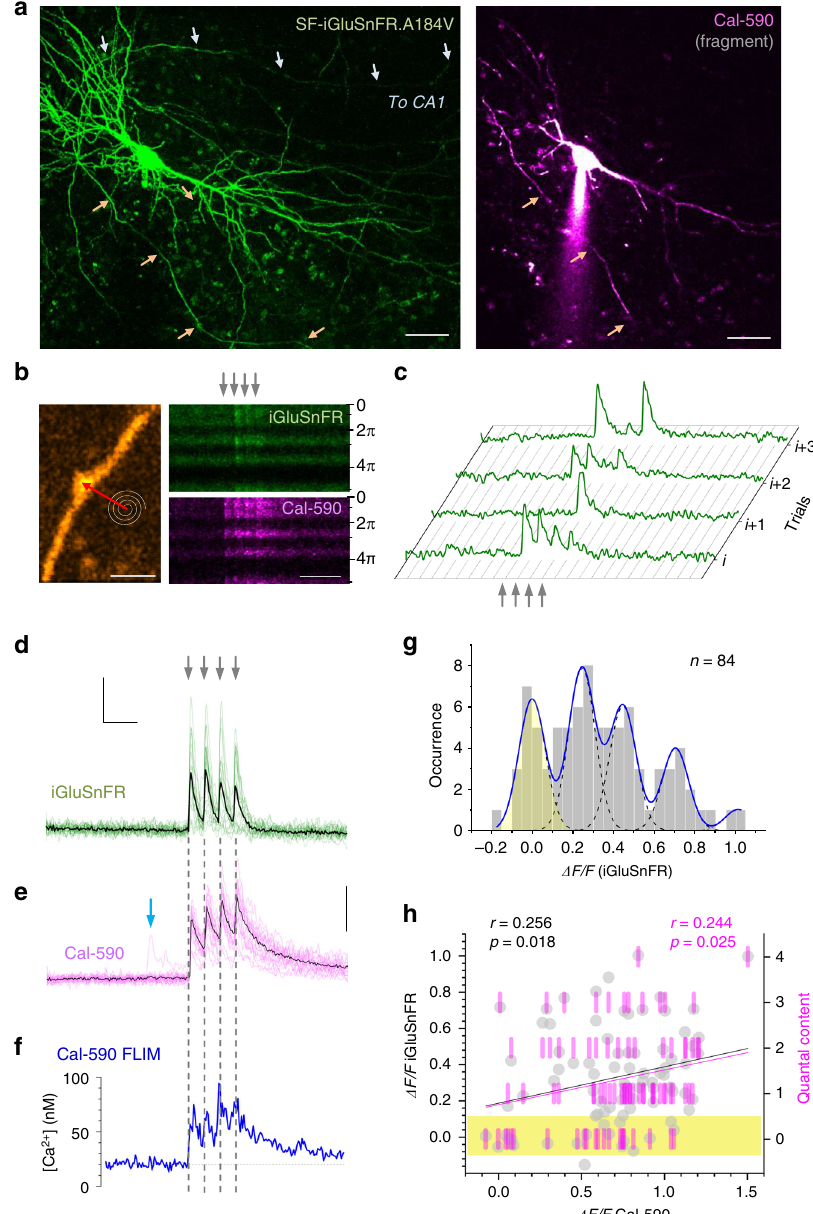
Fig. 3 Multiplex imaging of quantal glutamate release and presynaptic Ca 2 + dynamics. a CA3 pyramidal cell. Left: SF-iGluSnFR.A184V channel 7 (Methods); arrows, two main axonal branches; ~60 µ m z -stack, λ x 2p = 910 nm. Right, Cal-590 channel (~20 µ m z -stack fragment), whole-cell (300 µ M Cal-590); patch pipette seen; scale bars, 20 µ m. b Axonal bouton traced into CA1 from CA3 pyramid 9,49 : left, SF-iGluSnFR.A184V channel; tornado scan position shown; right, tornado linescan examples (rotation angle 0 – 5 π rad re fl ects 2.5 spiral circles) during four evoked action potentials (APs; 20 Hz, arrows) shown in SF- iGluSnFR.A184V (green, note release failures) and Cal-590 (magenta) channels; scale bars, 2 µ m (left), 200 ms (right). c Four characteristic sequential one-sweep recordings (SF-iGluSnFR channel) depicting individual quantal releases and failures. d Summary, glutamate release kinetics in bouton shown in b (SF-iGluSnFR.A184V channel; green, 20 trials 1 min apart; black, average); scale bars, 50% Δ F/F (vertical) and 100 ms (horizontal). e Summary, Cal-590 intensity signal Δ F/F (red channel) recorded as in d (magenta, individual trials; black, average); arrow, spontaneous Ca 2 + entry with no glutamate release (see d ); scale bar, 30% Δ F/F . f Dynamics of free presynaptic [Ca 2 + ] averaged over 20 trials: Cal-590 fl uorescence lifetime imaging microscopic readout (normalised photon count), converted to [Ca 2 + ]. Note: data re fl ect free ion concentration volume-equilibrated and time-averaged over 5 – 10 ms. g Amplitude histograms (SF-iGluSnFR.A184V Δ F/F signal, fi rst – to-fourth response counts combined; 8 ms pre-AP baseline subtracted); blue line, semi- constrained multi-Gaussian fi t (Methods); peaks correspond to quantal amplitudes; leftmost peak, zero signal (release failure noise; yellow shade); false- positive cut-off at ~0.12 Δ F/F . h Trial-to-trial glutamate release signal amplitude (bouton in b ) shown as Δ F/F SF-iGluSnFR.A184V readout (grey dots) and as quantal content (magenta bars, right ordinate; calculated from histogram in g ) plotted against evoked Ca 2 + entry signal ( Δ F/F Cal-590, as in e ) for all recorded APs (8 ms pre-AP baseline subtracted). Black and magenta lines, linear regressions ( r , Pearson ’ s correlation; p , regression slope signi fi cance) for Δ F/F and quantal content data, respectively; yellow shade, failure response cut-off (as in g